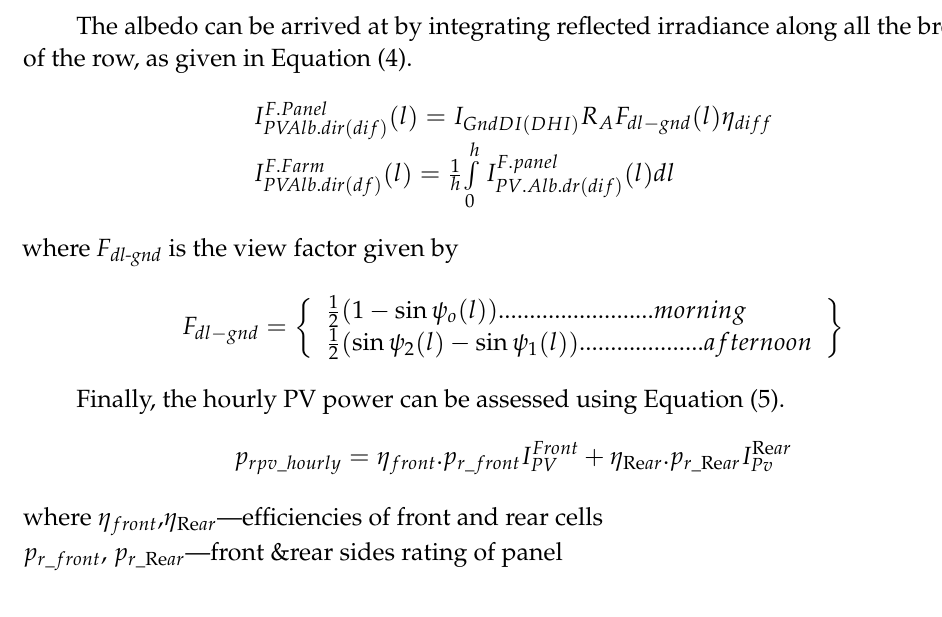
The albedo can be arrived at by integrating reflected irradiance along all the breadth of the row, as given in Equation